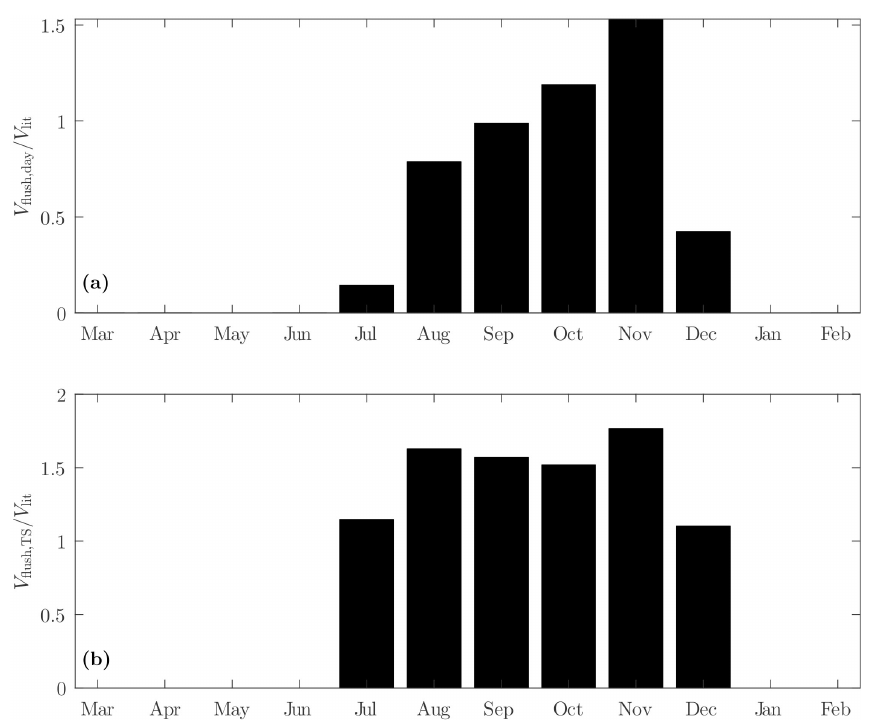
Figure C1. Fraction of the littoral region flushed by TSs in 1d for each month. Months with less than 10d of measurements have been removed as in Fig. 5 (May 2019 and January 2020). (a) The daily averaged flushed fraction including all days with measurements. (b) The daily averaged flushed fraction for days with TSs